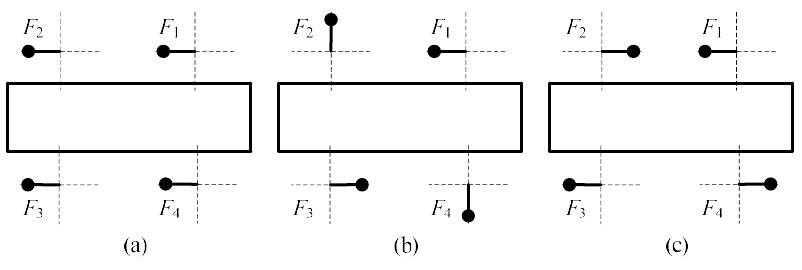
Figure 3. Force analysis of the system in steady-state motion: ( a ) Sub-resonant phase differences are 0 ◦ ; ( b ) Super-resonant phase differences are | 90 ◦ | ; ( c ) Super-resonant phase differences are | 180 ◦ |